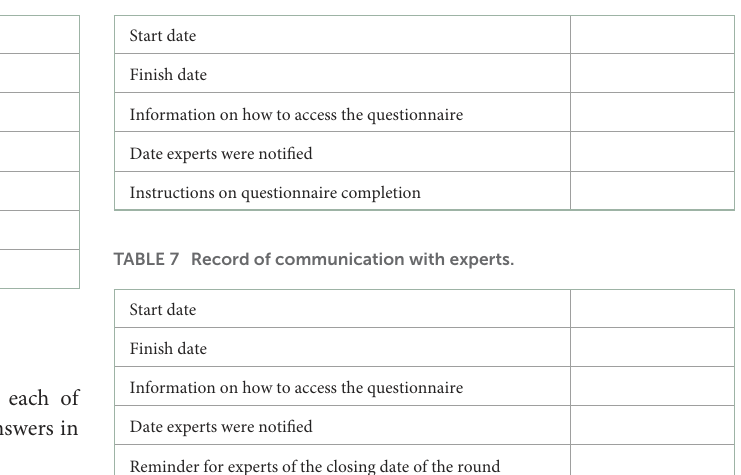
TABLE 6 Record of the